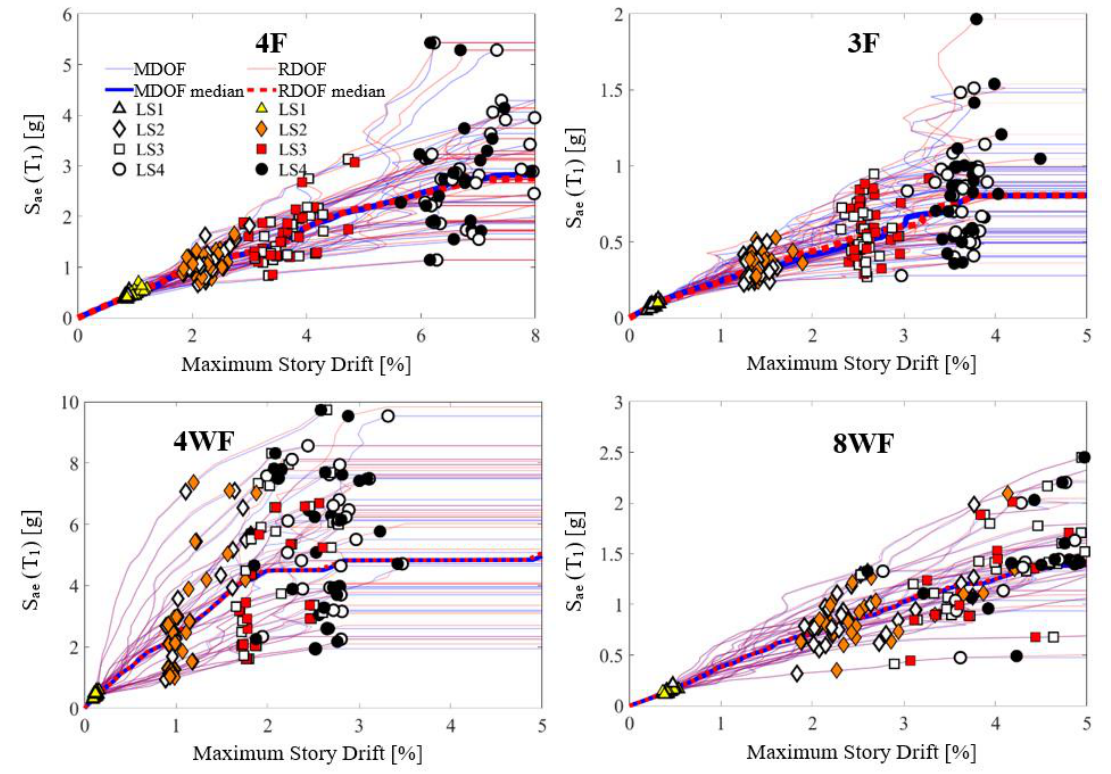
Figure 9. IDA curves for each ground motion, the corresponding median IDA curve, and the limit-state points for the RDOF and MDOF model of 4F, 3F, 4WF, and 8WF building. IDA curves are presented in the format of spectral accelerations at the fundamental period of building, S ae (T 1 ) versus maximum storey drift.